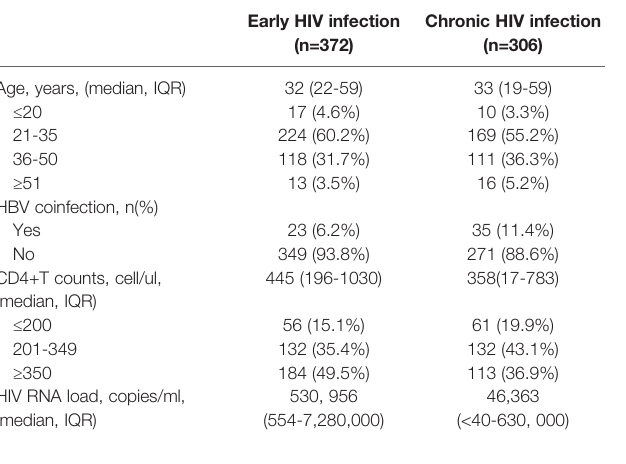
TABLE 1 | Characteristics of patients in the early and chronic HIV infection